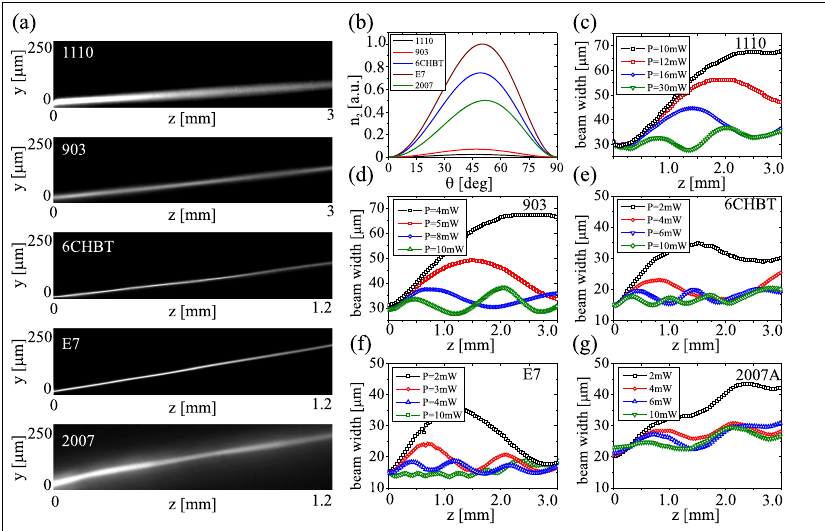
Figure 4. ( a ) Acquired images of P = 10mW nematicon propagation in the five NLC mixtures, as labelled. ( b ) Calculated nonlinearity versus θ 0 for each material. ( c – g ) Beam-width evolution versus propagation for various input powers (see legends), and for the five mixtures, as labelled. As power increases, the breathing period decreases. The relative values are coherent with the graphs in panel ( b ): a larger nonlinear figure is associated to a shorter